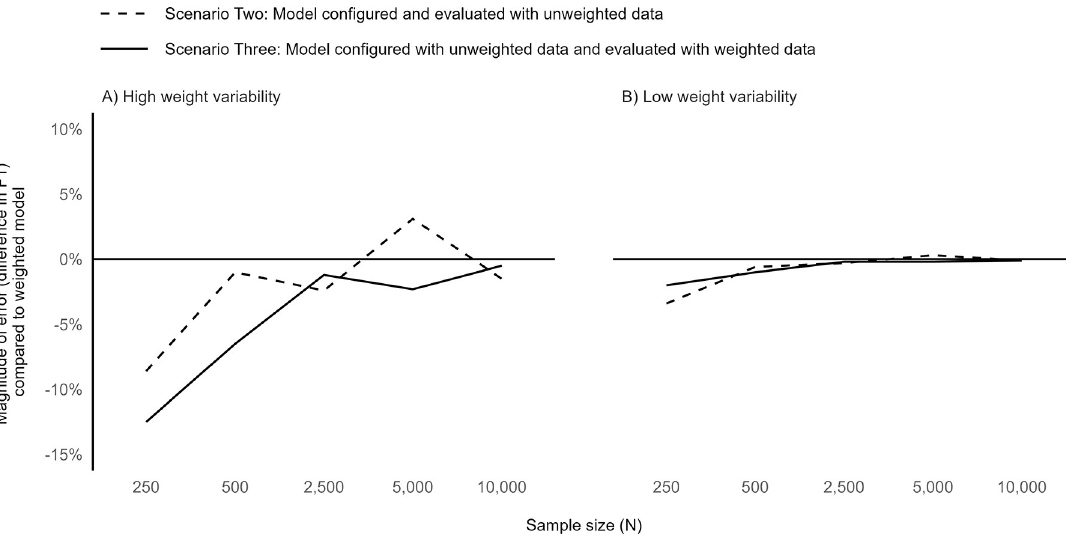
Fig 2. Performance of unweighted versus weighted gradient boosting model implementations by weight variability and sample